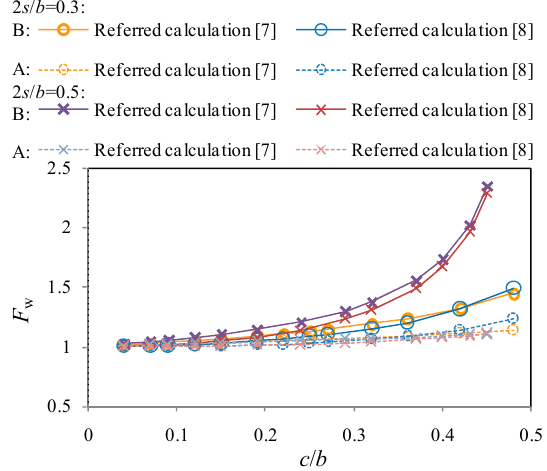
Figure 7. Comparison of referred calculations of stress intensity factors (SIF) at A and B.